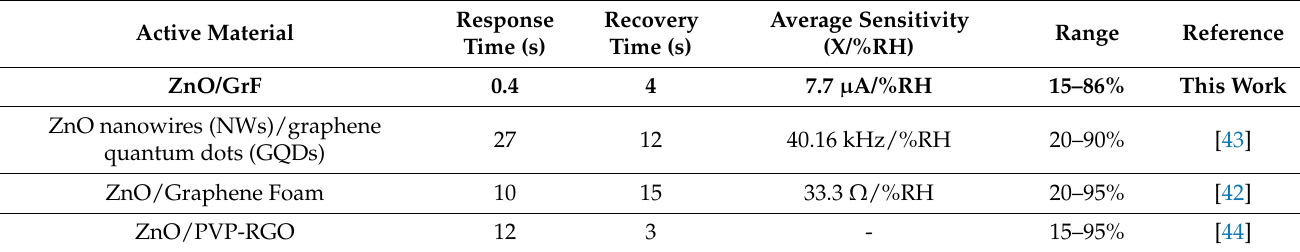
Table 2. A comparison table of proposed work and the other reported ZnO/Graphene humidity sensors. Active Material